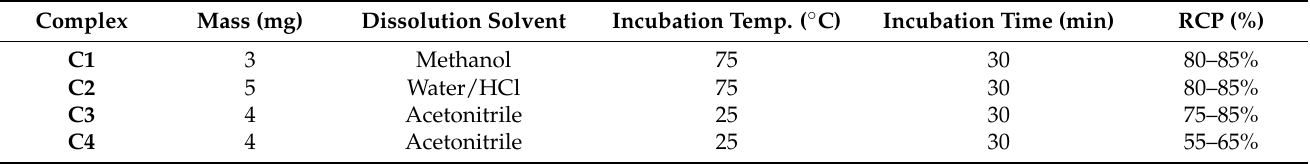
Table 1. Optimized preparation conditions of 99m Tc complexes.